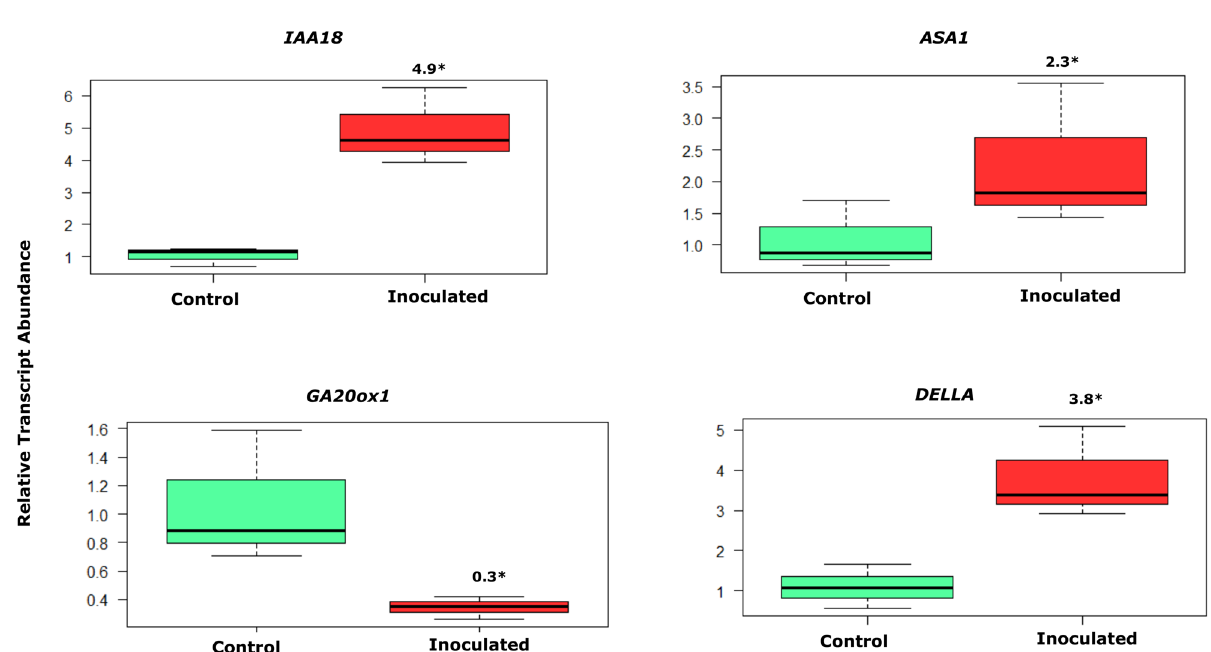
Figure 6. Relative transcript abundance of genes encoding biosynthesis of auxin and gibberellins in roots of control and inoculated Bd21-3 at 28 dpi. Numbers above the box plots represent fold change. Independent Student t-test was used to determine the statistical differences between inoculated and control roots. *indicates significance ( p <